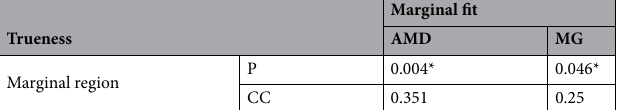
Table 3. Results of the correlation analysis between marginal fit and trueness of the marginal region. AMD absolute marginal discrepancy, MG marginal gap, CC correlation coefficient. *Significance determined by Pearson correlation analysis, P <